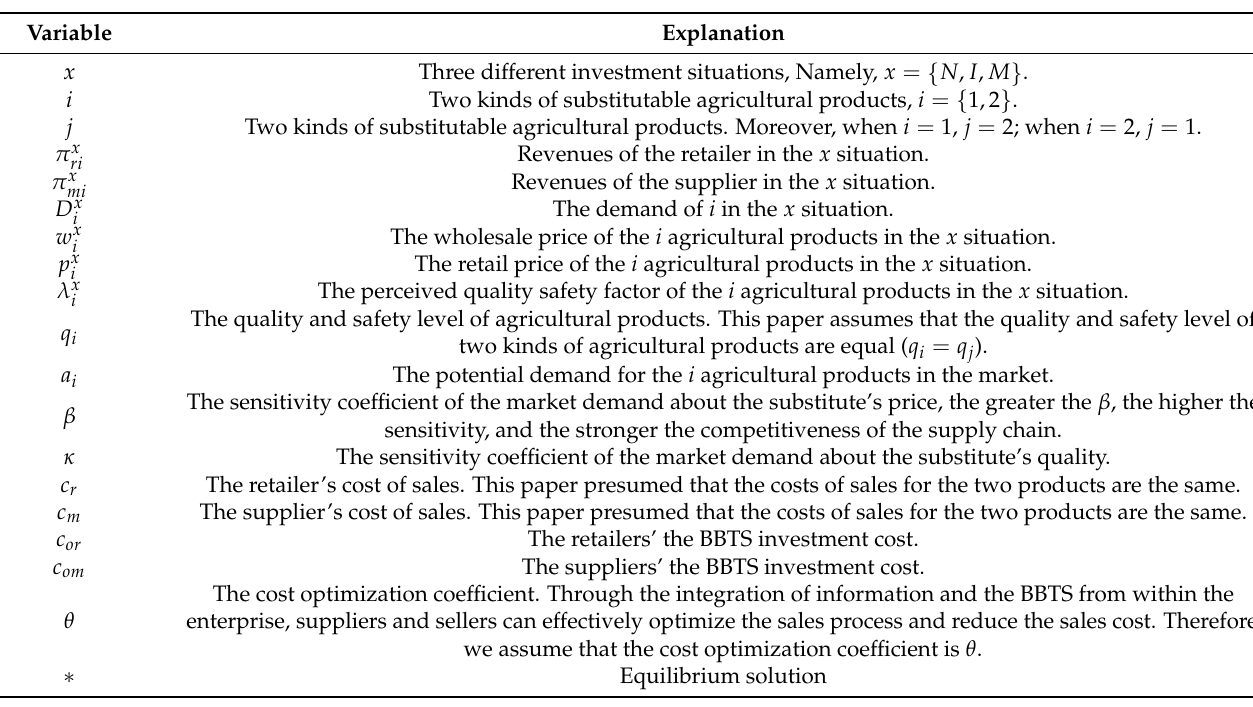
Table 1. Variable